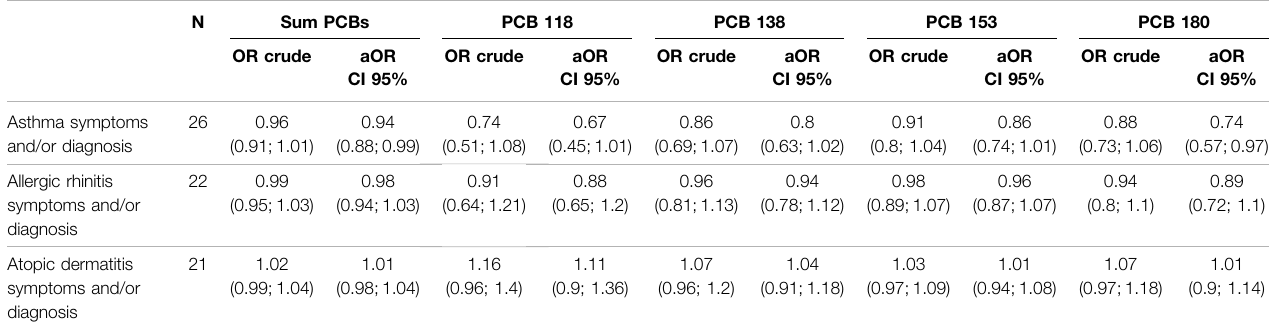
TABLE 5 | The association between PCBs (lipid-adjusted) serum levels and asthma, allergic rhinitis and atopic dermatitis diagnosis and/or